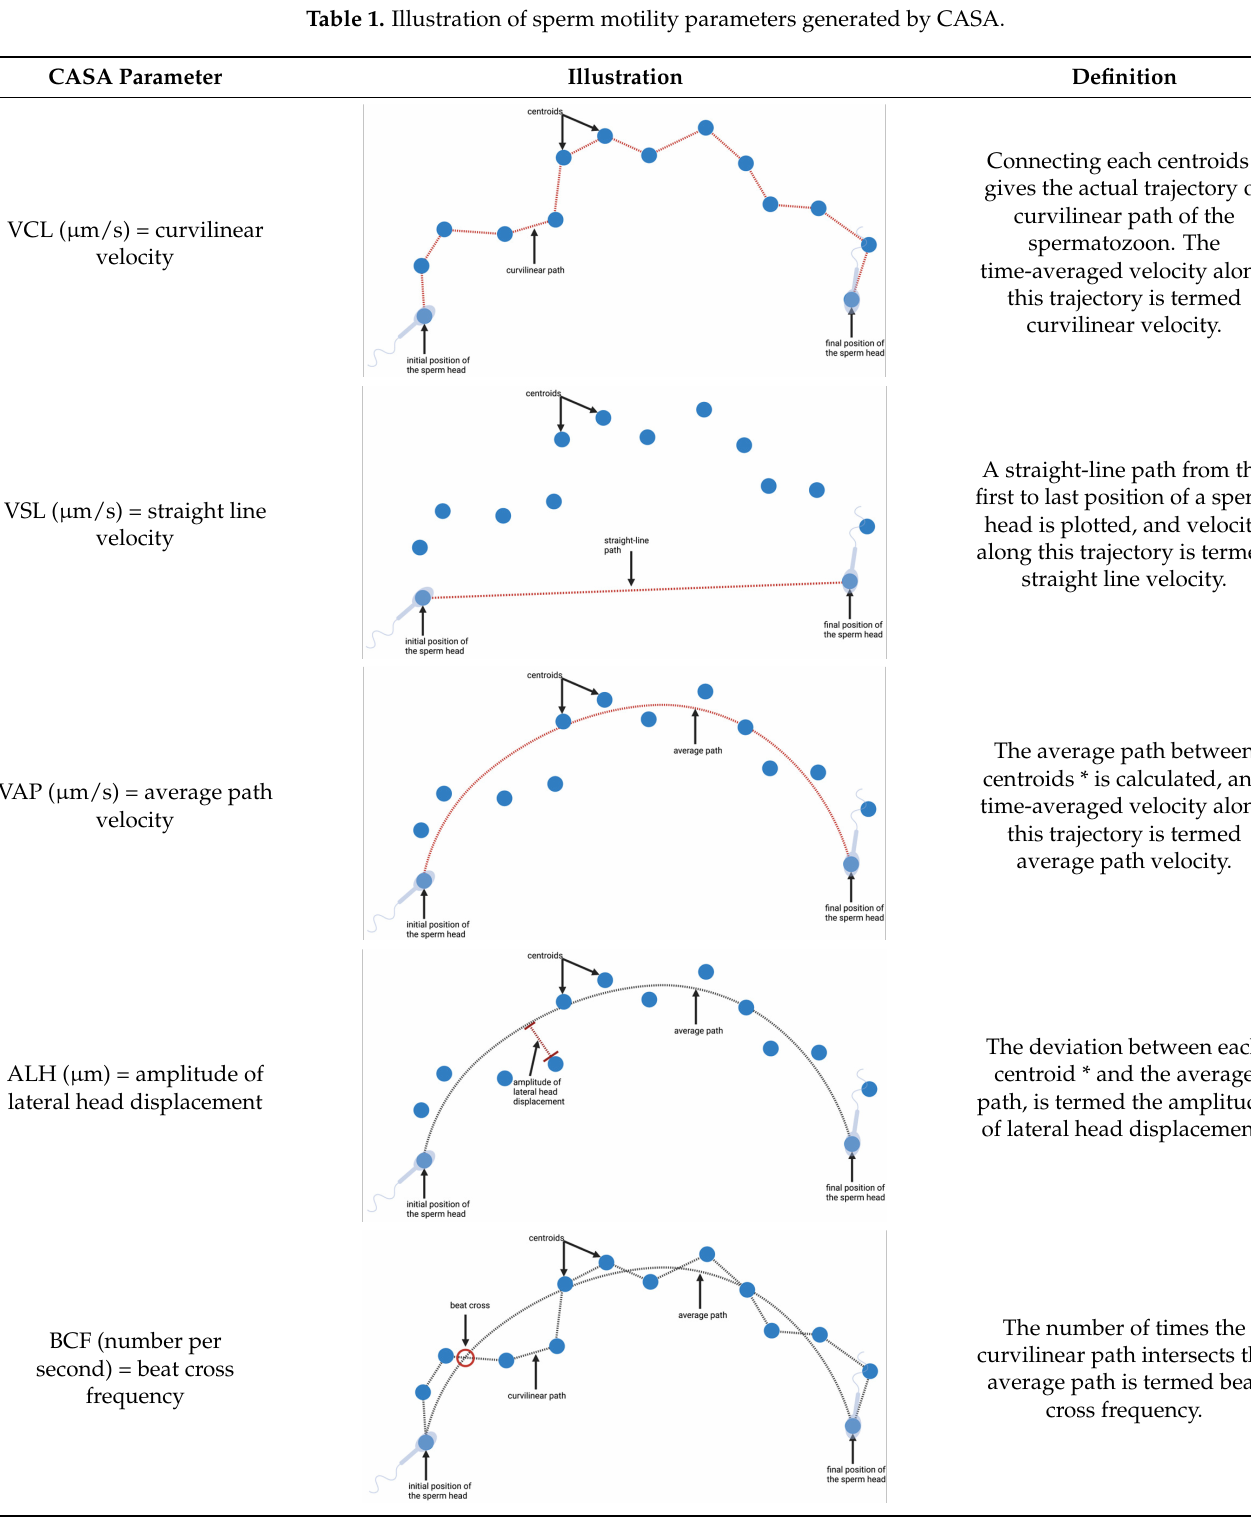
Table 1. Illustration of sperm motility parameters generated by